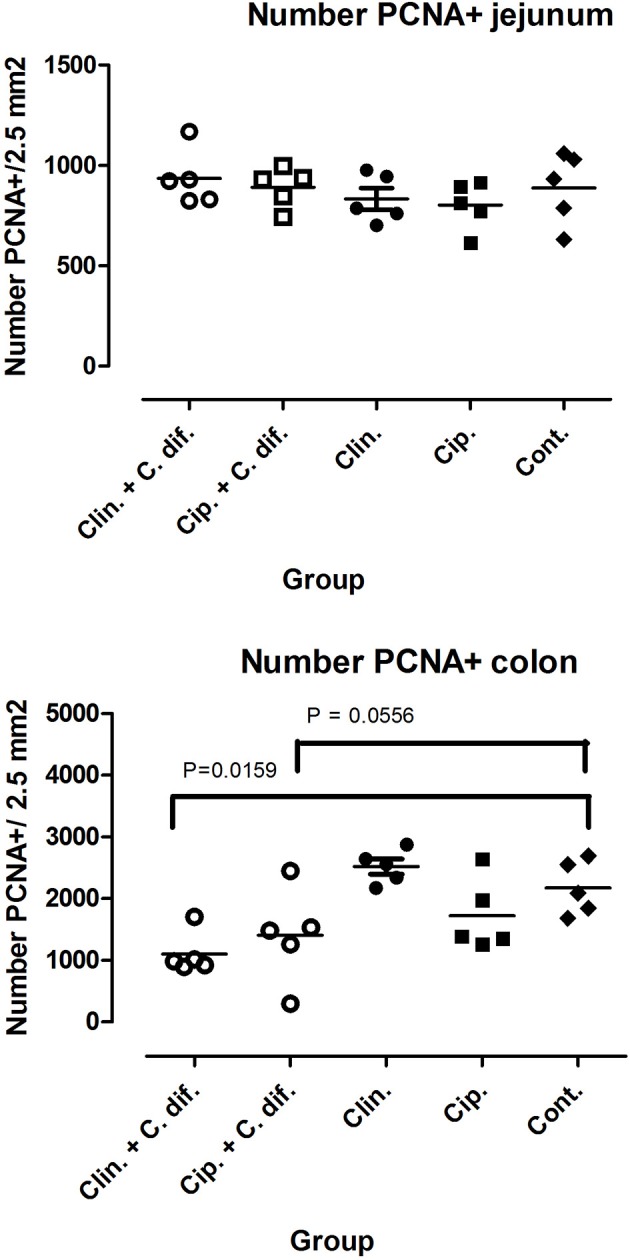
Decreased cell proliferation rates in the colons of C. difficile-inoculated pigs. Number of PCNA positive cells in jejunal (Top) and colon (Bottom) tissue. Significance of differences between treatments was determined using Mann-Whitney tests.